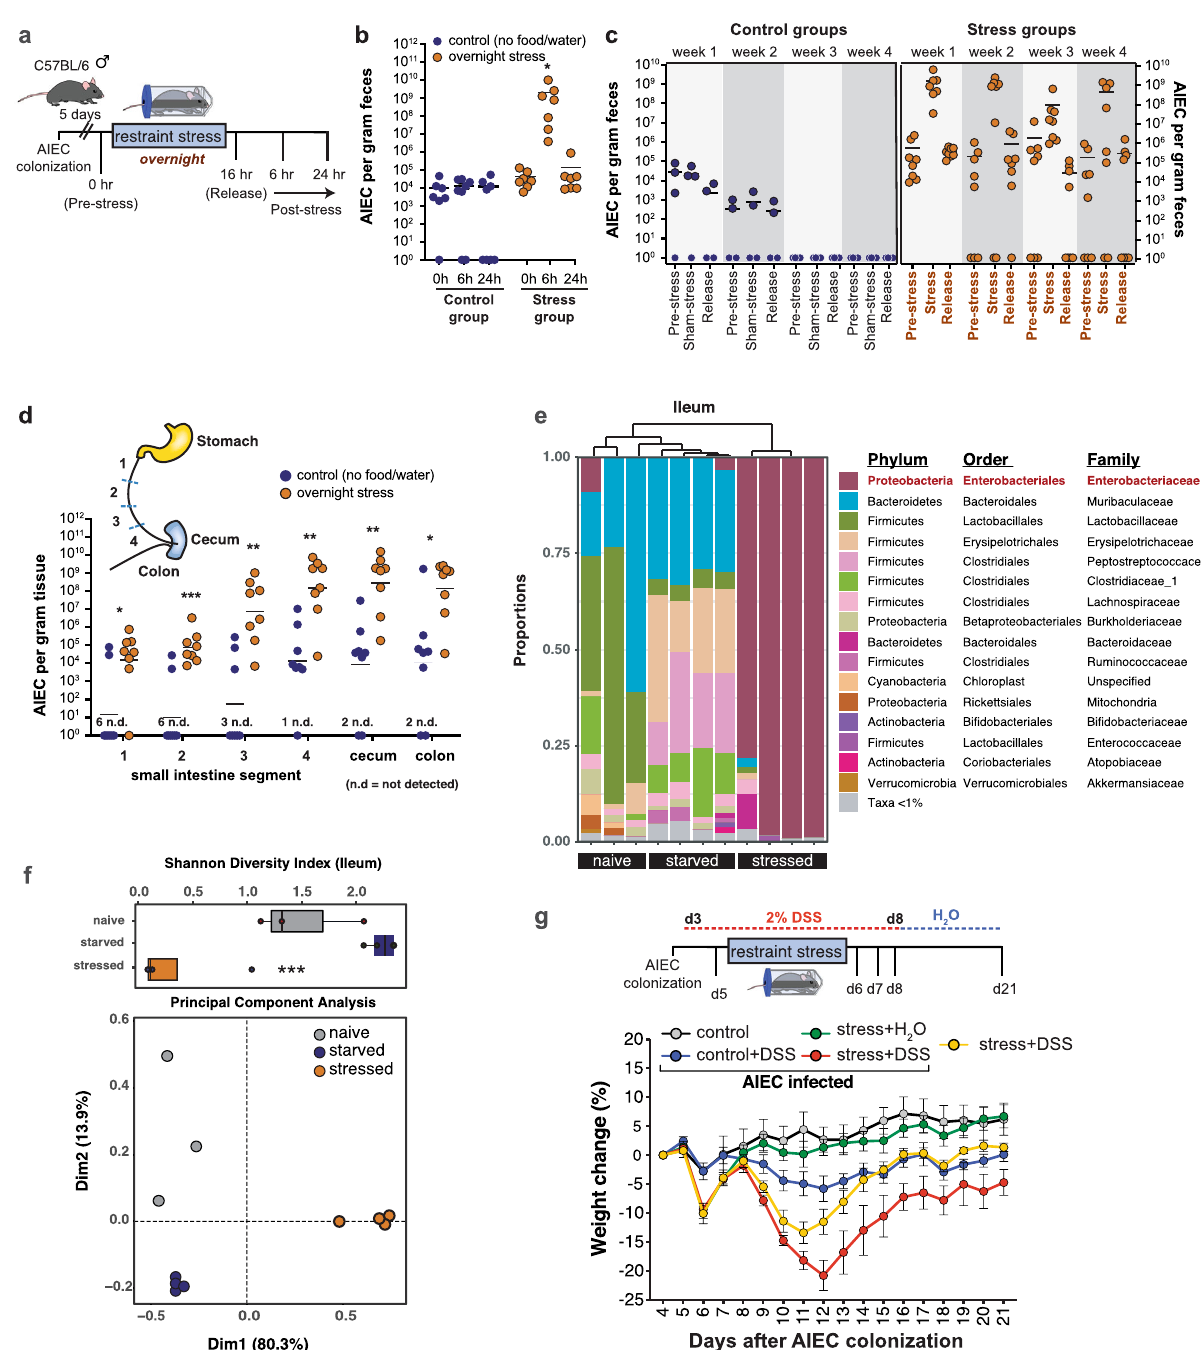
Fig. 2 Psychological stress impairs host control of CD-associated AIEC. a Schematic representation of infection and stress protocol. b AIEC fecal burdens collected from control ( n = 8) and stress ( n = 7) exposed mice at the time of stress (or overnight starvation), and at 6 and 24 h post-stress. Stress- exposed mice were compared to matched controls by a two-way ANOVA, not corrected for multiple comparisons, p = 0.0194. c Mice were colonized with AIEC and subjected to either overnight stress ( n = 8) or starvation ( n = 4) for 16 h weekly for 4 weeks. Fecal samples were collected at the time of stress (or overnight starvation), and at 6 h and 24 h post-stress. d AIEC tissue burdens collected from the length of the intestinal tract from control ( n = 8) and stress ( n = 8) mice. The small intestine was divided into four 8 cm segments in which segment 4 is adjacent to the cecum. Stress-exposed mice were compared to match controls by a two-tailed Mann – Whitney test, p values = 0.022067, 0.000932, 0.001088, 0.001865, 0.001088, 0.020202. e Taxonomy plot of 16S rRNA sequencing of ileum in AIEC-colonized naive ( n = 3), starved (food and water depleted, n = 4), and restraint-stress ( n = 4) exposed mice. f Shannon diversity index and principal component analysis of ileal 16S rRNA sequencing from AIEC-colonized naive ( n = 3), starved ( n = 4) and stress ( n = 4) mice. For Shannon Diversity Index, signi fi cance between starved and stressed mice, p = 0.0004 was determined by one-way ANOVA. Box plot represents median and 25th and 75th percentiles — interquartile range; IQR — and whiskers extend to maximum and minimum values, adjusted for multiple comparisons. g Schematic representation of DSS treatment schedule. The graph depicts weight change from the time of DSS initiation (all groups are n = 4) (* p ≤ 0.05; ** p ≤ 0.01; *** p ≤ 0.001). Error bars represent SEM and the line in CFU graphs indicates the geometric mean of the group.